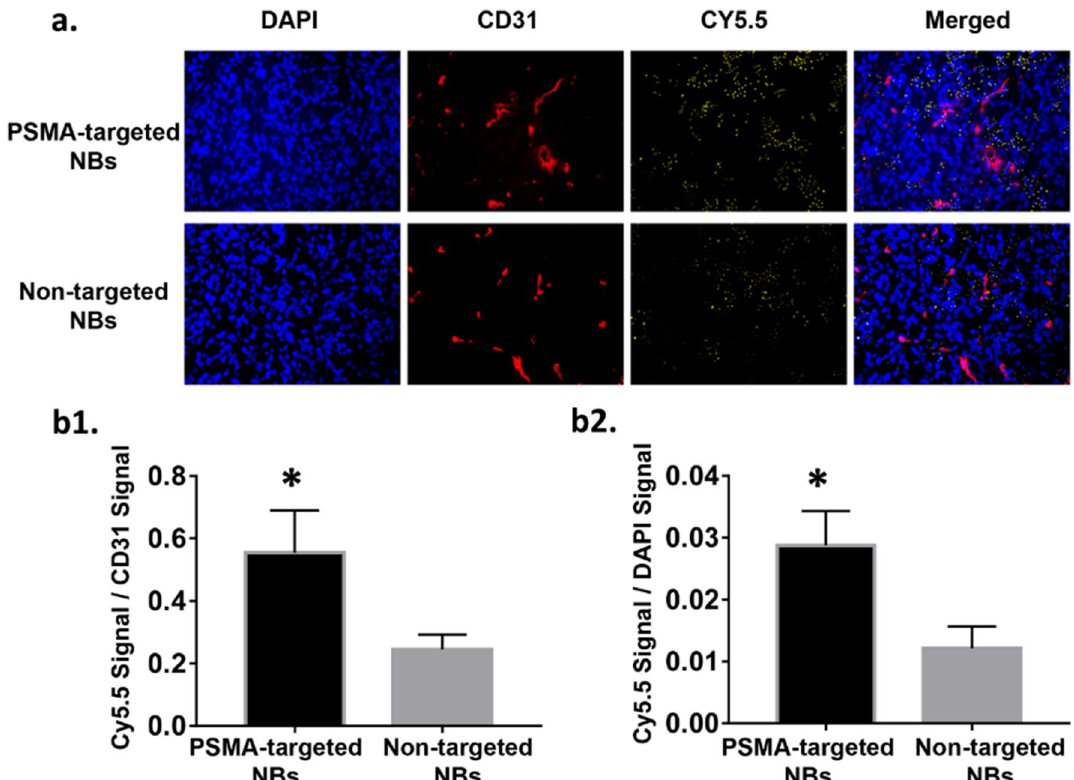
N = 3 for both PSMA-1-targeted group and non-targeted group. ( b1 ) Quantification of fluorescence ratio (total bubbles fluorescence/vessels fluorescence per field). Data are presented as mean ± standard deviation; * p < 0.05, targeted group vs. non-targeted group, n = 3. ( b2 ) Quantification of fluorescence ratio (total bubbles fluorescence/cells fluorescence per field). Data are presented as mean ± standard deviation; * p < 0.05, targeted group vs. non-targeted group, n =